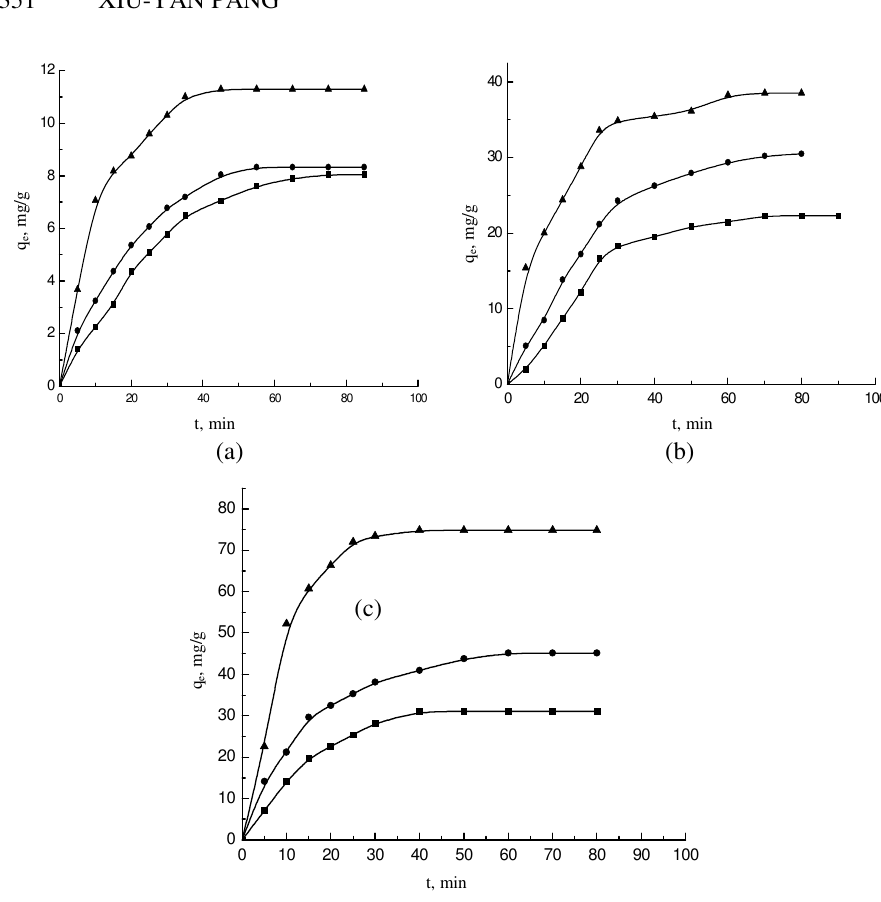
Figure 4. Influence of PEG (4000) concentration and temperature on adsorption kinetics. (a) 50 mg/L, (b) 200 mg/L, (c) 500 mg/L; ( ■ )5 °C, ( ● )25 °C, ( ▲ )45